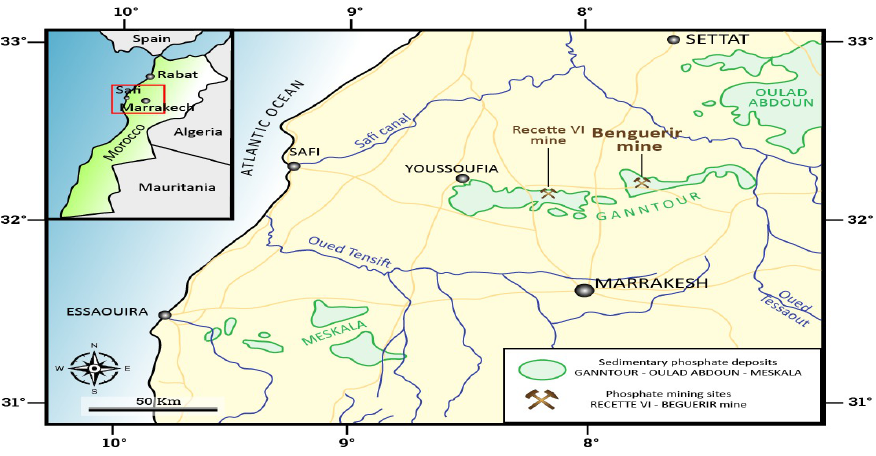
Figure 1. Geographical location of the studied mine site.